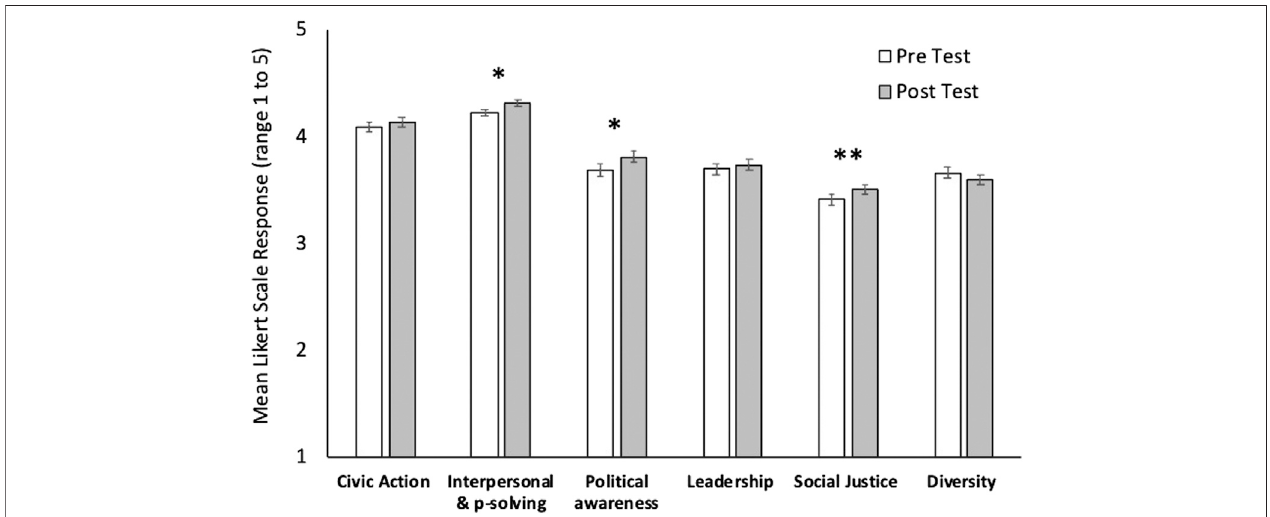
FIGURE 1| Difference between the average responsebetween the pre and post tests for the CASQ data in the Fall2016 semester with standard error shown ( n (cid:1) 174). Signi fi cant differences in the paired t -test between pre and post-test is indicated with a ** ( p < 0.05) and a *( p < 0.1).